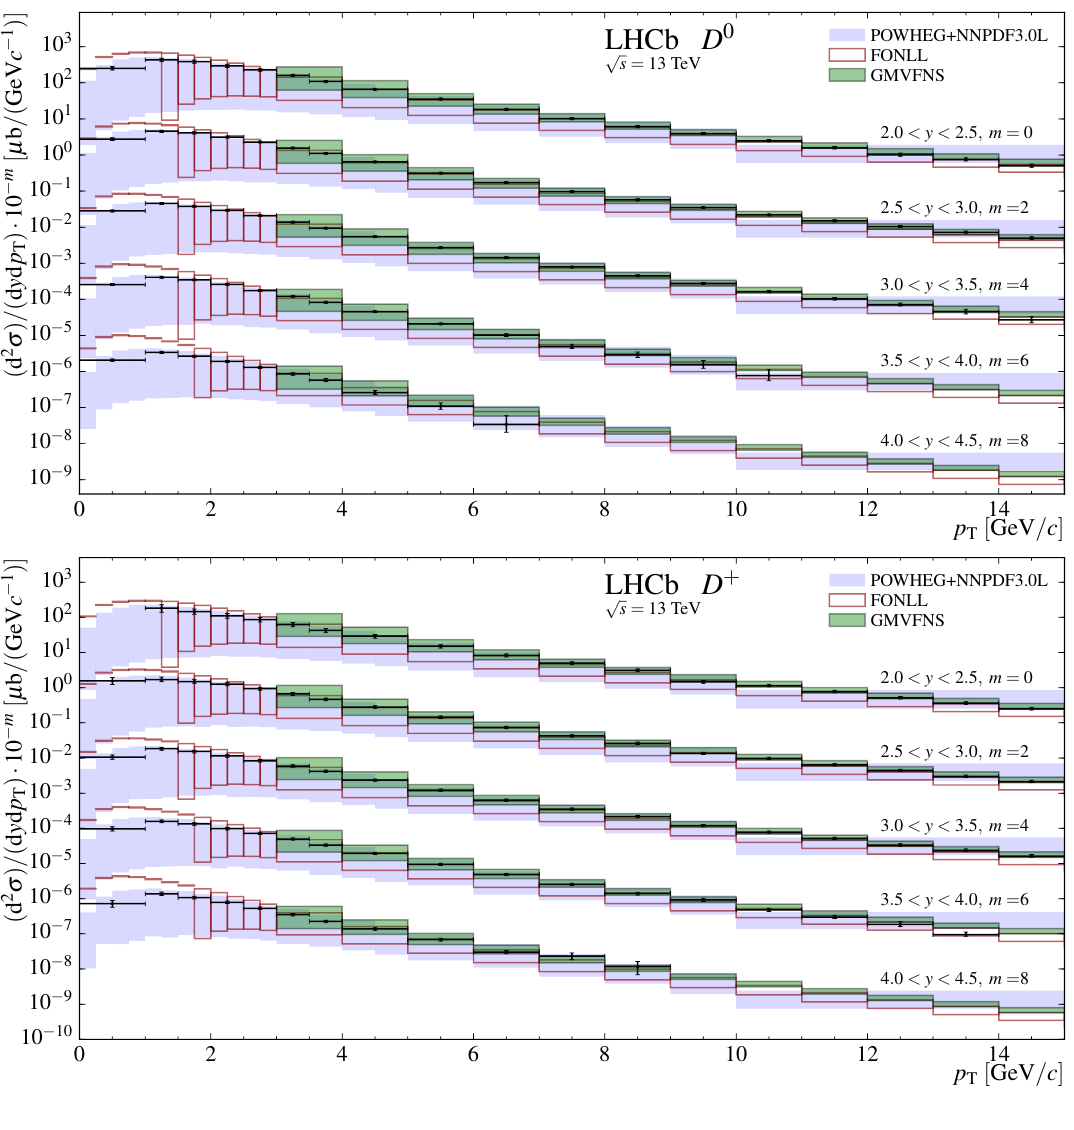
Figure 5. Measurements and predictions for the absolute prompt (top) D 0 , and (bottom) D + cross-sections at p s = 13 TeV. Each set of measurements and predictions in a given rapidity bin is o(cid:11)set by a multiplicative factor 10 (cid:0) m , where the factor m is shown on the plots. The boxes indicate the 1 (cid:27) uncertainty band on the theory predictions. In cases where this band spans more than two (cid:6) orders of magnitude only its upper edge is indicated.